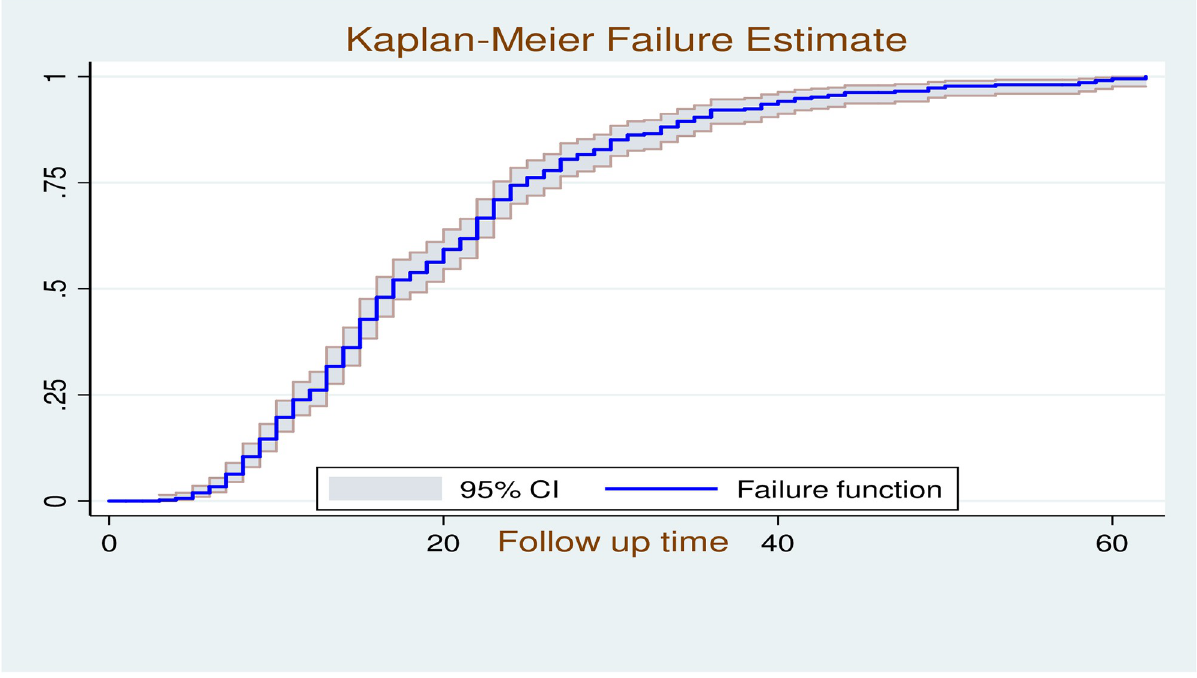
Fig 3. Log rank survival estimates for time to recovery among SAM children in SPHMMC form 2012 to 2019.